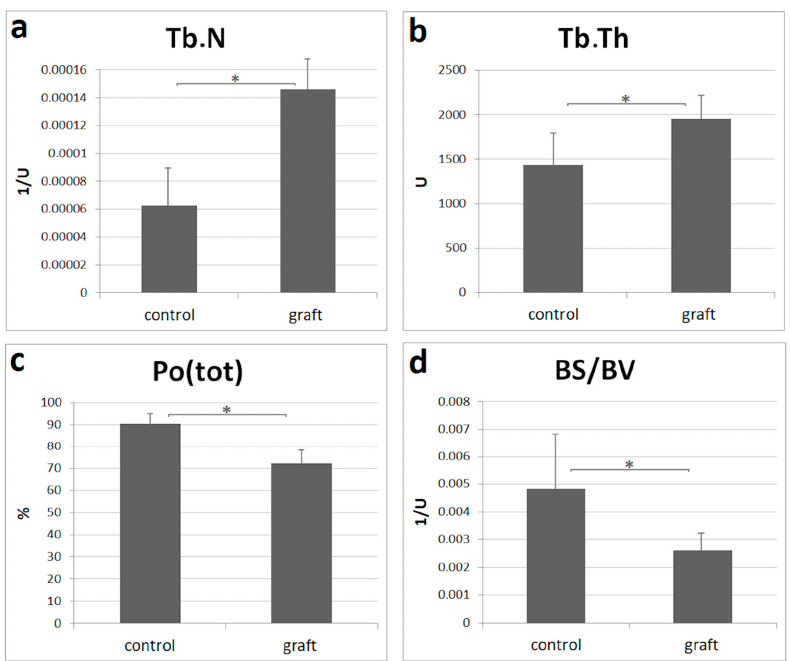
Figure 3. One year micromorphometry analysis: ( a ) trabecular number (Tb.N) is the total number of trabeculae per unit of length; ( b ) trabecular thickness (Tb.Th) indicates the mean thickness of trabeculae; ( c ) total porosity (Po(tot)) shows the total number of open and closed pores; ( d ) bone surface/volume ratio (BS/BV) refers to the volume ratio of calcified tissues; control: n = 11, graft: n = 11. All data are presented as mean ± SD. Statistical significance ( p < 0.05) was marked by an asterisk. Appl. Sci. 2021 , 11 , x FOR PEER REVIEW